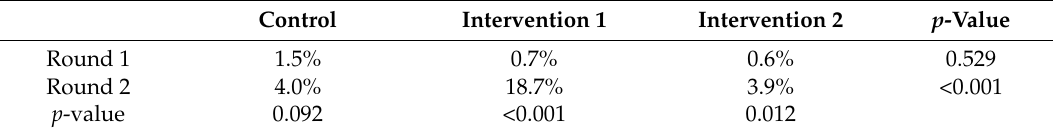
Table 5. DDI-related performance by intervention arm and round: Identification of specific DDI.